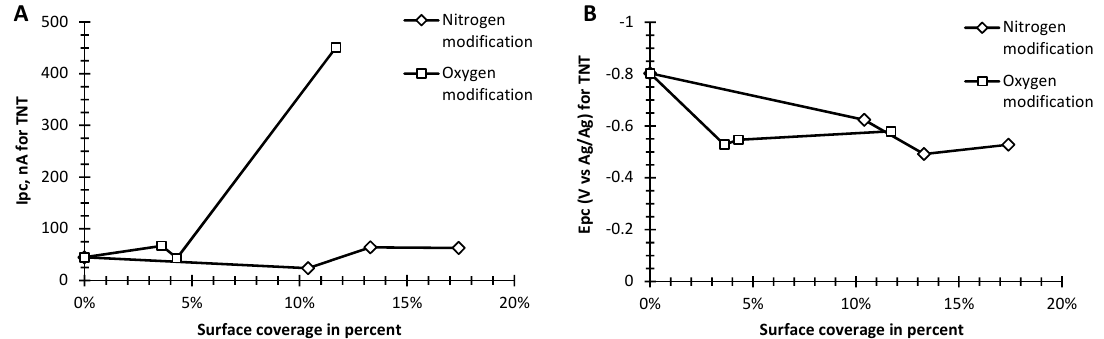
Figure 4. ( A) Net cathodic peak current ( I pc ) and ( B ) cathodic peak potential ( E pc ) vs. surface coverage in percent of nitrogen ( ♦ ), and oxygen ( ) with bare graphene at 0%. (cid:50)